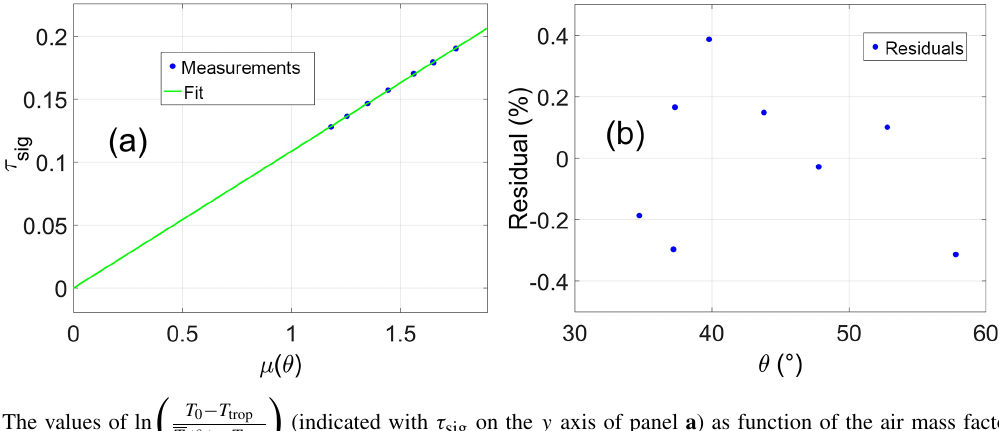
(cid:18) (cid:19) T 0 − T trop Figure 3. (a) The values of ln (indicated with τ sig on the y axis of panel a ) as function of the air mass factor µ(θ i ) (blue T(θ i ) − T trop points) measured during a tipping curve on 10 December 2016, and the fit result (green line). (b) The residuals (measurements minus fit) as a function of the elevation angle.